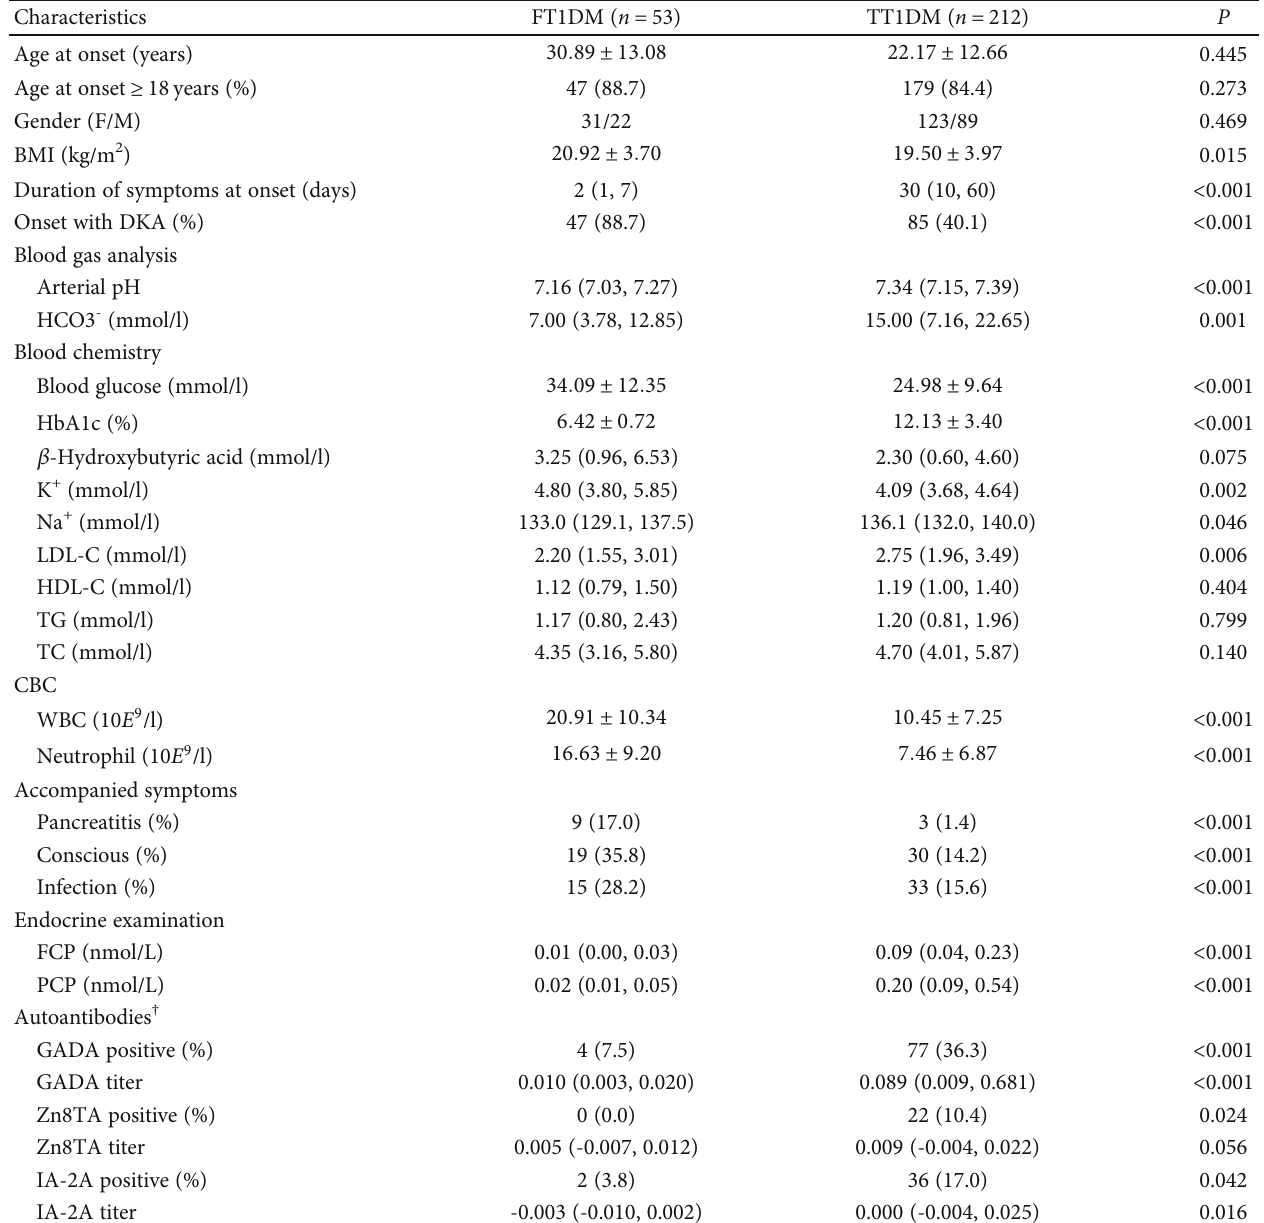
Table 1: Clinical characteristics at the onset between FT1DM and